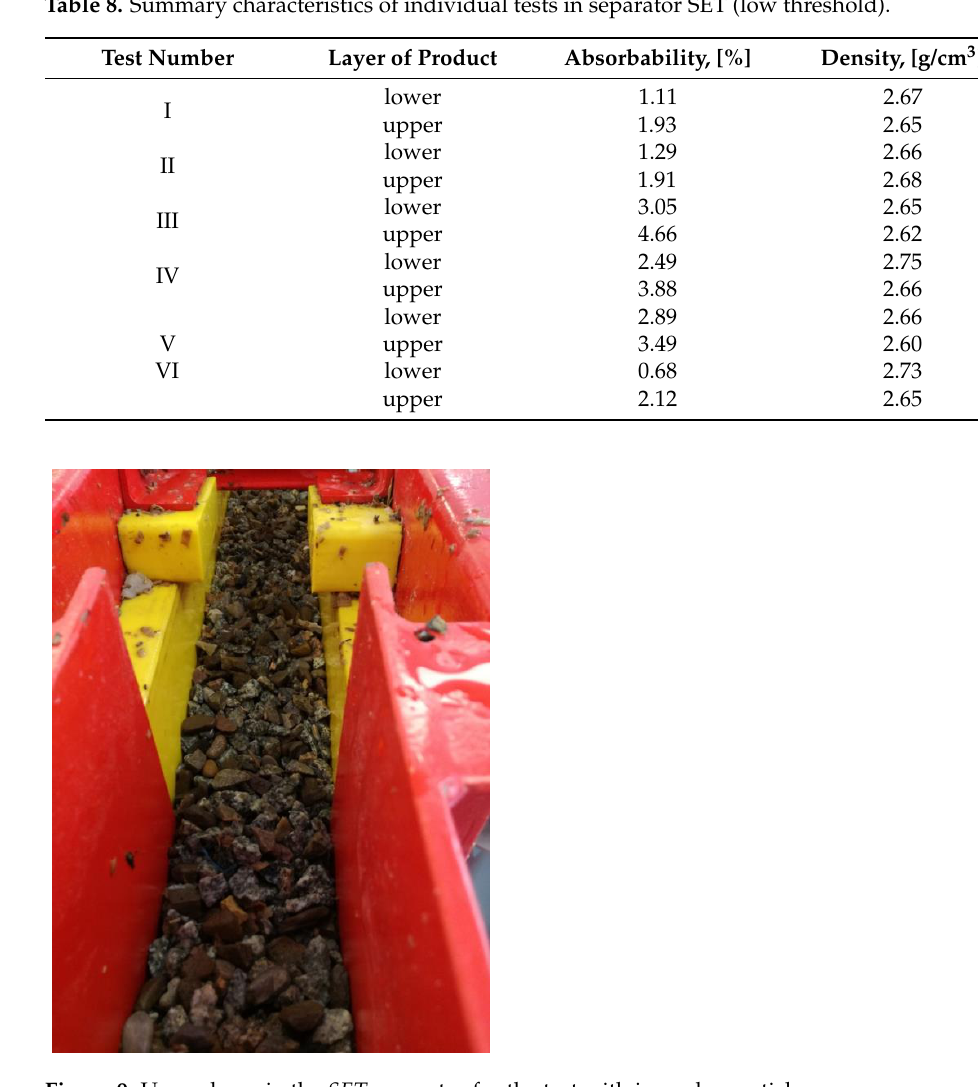
Table 8. Summary characteristics of individual tests in separator SET (low threshold).